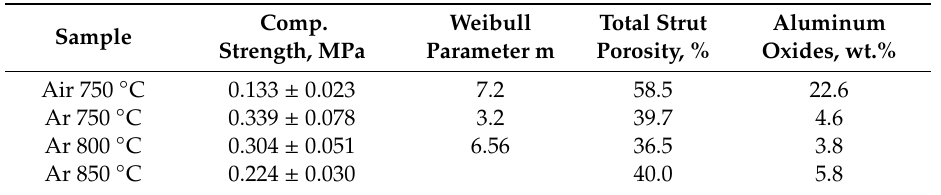
Figure 6. ( a , b ) Stress–strain curves and ( c ) foams after compressive strength test for a foam processed in Ar (left) and in Air (middle) for 3 h at 750 °C. Table 5. Total porosity, open strut porosity, and compressive strength of aluminum foams thermally processed for 3 h at 750 °C in air and at 750–850 °C in Ar.